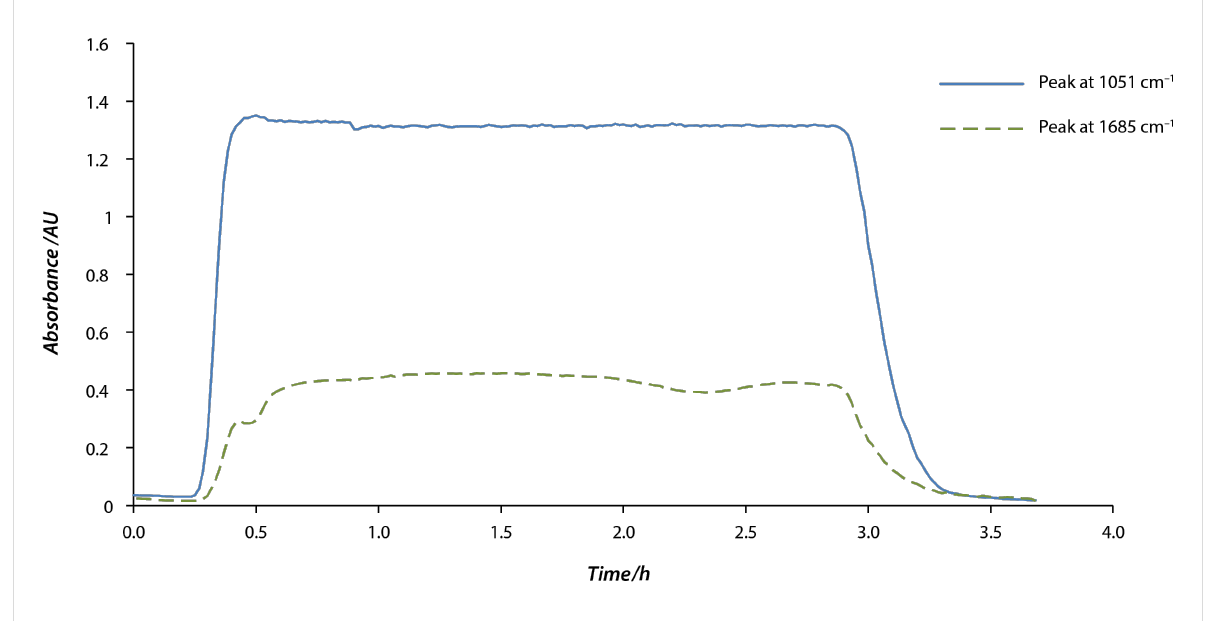
Figure 4: FlowIR™ profile for the reactor output after hydration of pyrazine-2-carbonitrile using hydrous zirconia. Both peaks correspond to the prod- uct. A solution of the nitrile in ethanol (0.06 M) was passed at 0.1 mL min − 1 through the column, heated to 100 °C. The response rises after approxim- ately one column volume, with a small degree of dispersion. It then starts to decrease after the water is used up and the ability of the column to hydrate is exhausted. The fall-off takes place over about one column volume, indicating a low retention of material by the heterogeneous bed.